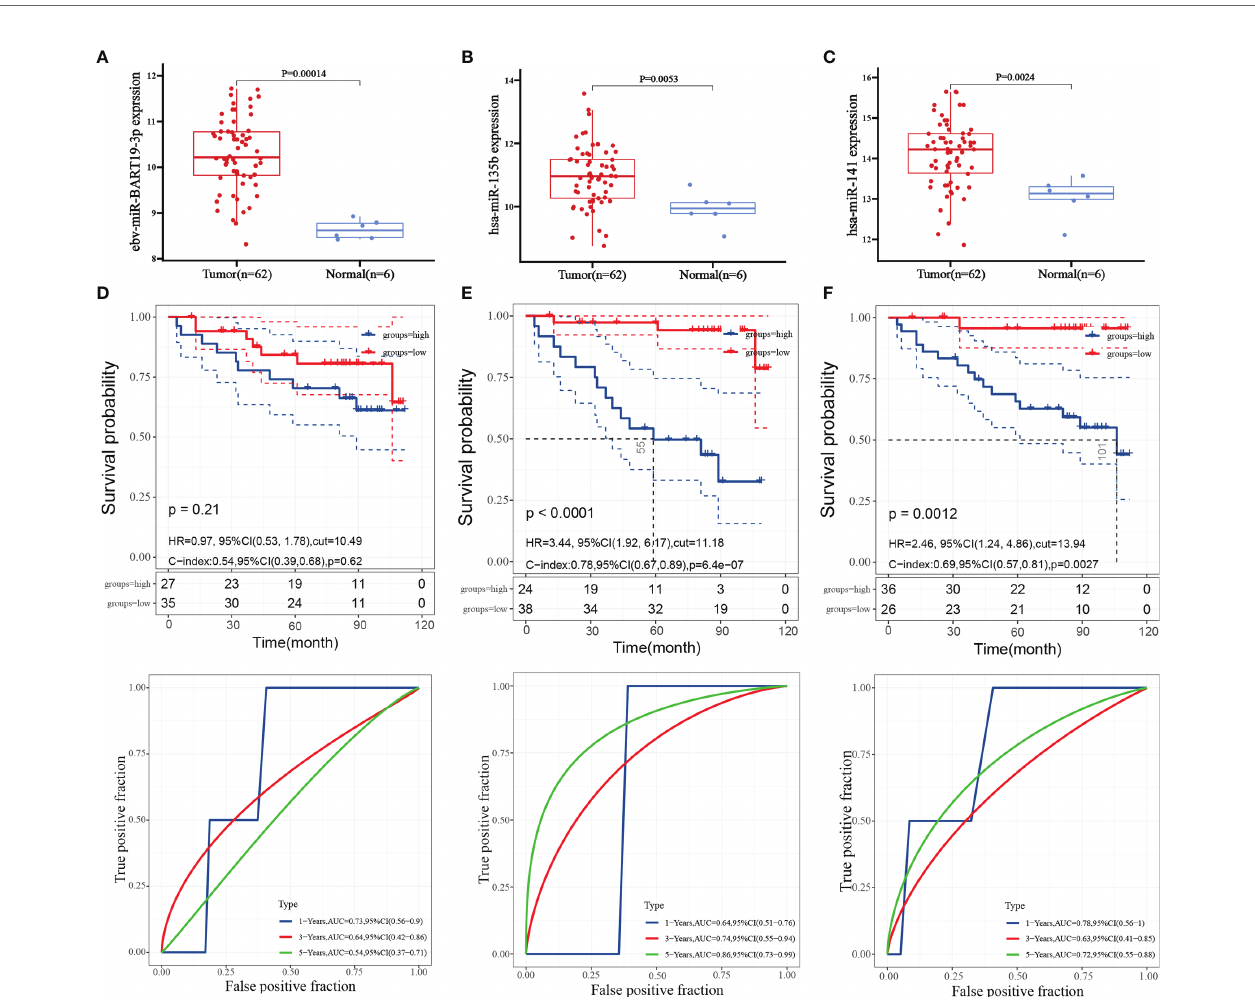
FIGURE 4 | Hub miRNA expression and survival prognosis. (A) expression level of ebv-miR-BART19-3p; (B) expression level of hsa-miR-135b; (C) expression level of hsa-miR-141; (D) Kaplan-Meier survival curve and ROC curve of ebv-miR-BART19-3p; (E) Kaplan-Meier survival curve and ROC curve of hsa-miR-135b; (F) Kaplan-Meier survival curves and ROC curves for hsa-miR-141.